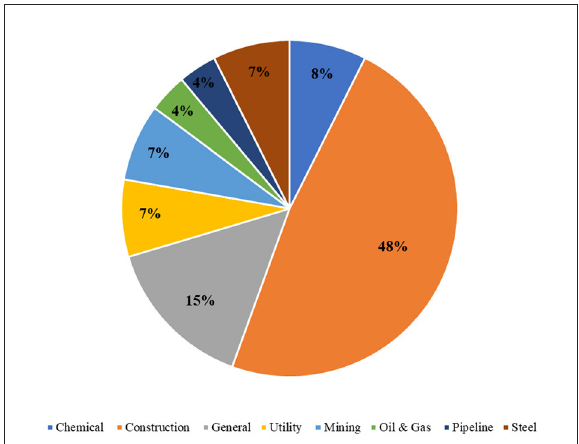
FIGURE4 Industrial sectors in existing